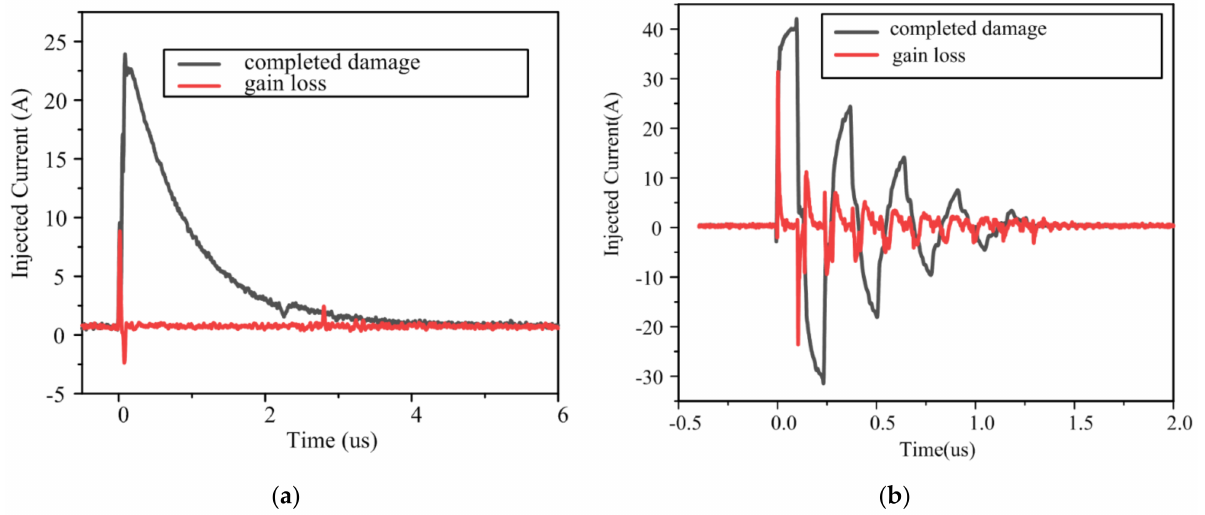
Figure 6. Injection waveform comparison of a HEMP conducted environment: ( a ) 20 ns/500 ns EMP; ( b ) square wave with 100 ns